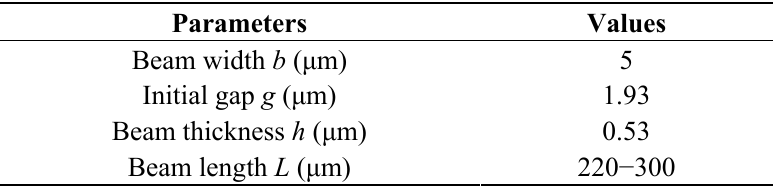
Table 6. Geometrical parameters of the bridge-type test beams.